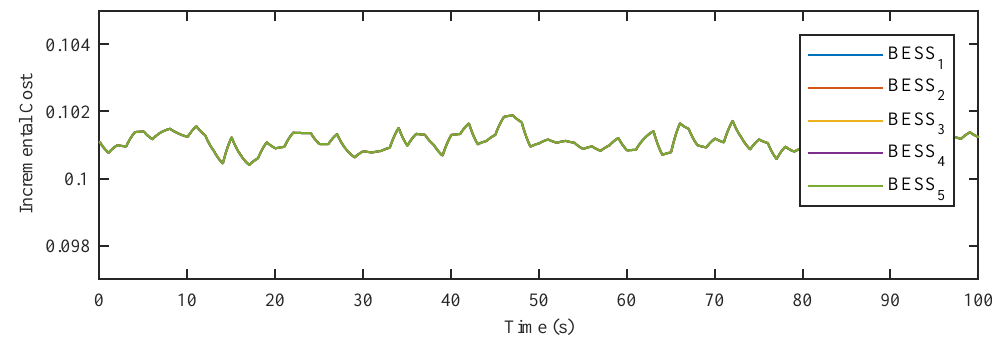
Figure 20. Convergence curve of incremental